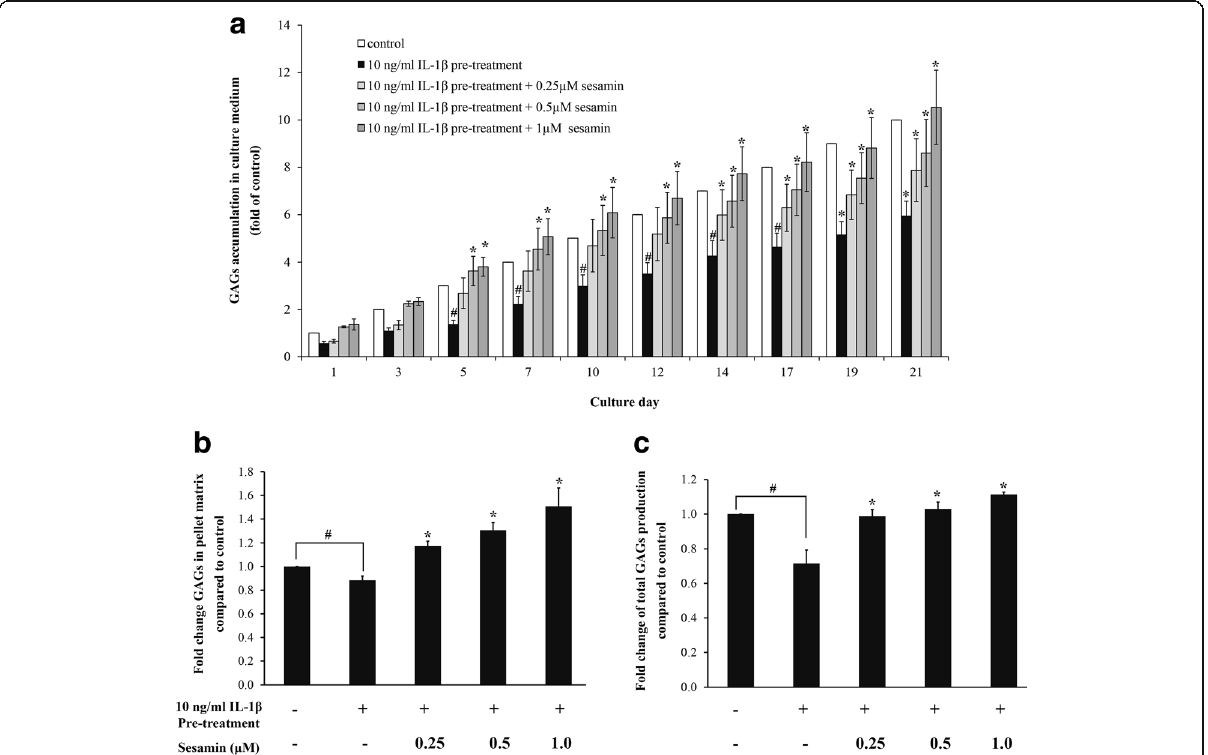
Fig. 4 The effects of sesamin on GAGs production in IL-1 β 3-day pre-treated HAC pellets. a Effects of sesamin on GAGs secretion to the culture medium over 21 days; b GAGs accumulation in the pellet matrix after 21 days treatment; and c total GAGs production after 21 days treatment. Data presented are the mean ± S.D. of three independent cultures. Statistical significance of the difference between IL-1 β pre-treatment alone and untreated (control): # = p < 0.05; between sesamin treatment and IL-1 β pre-treatment alone: * = p < 0.05